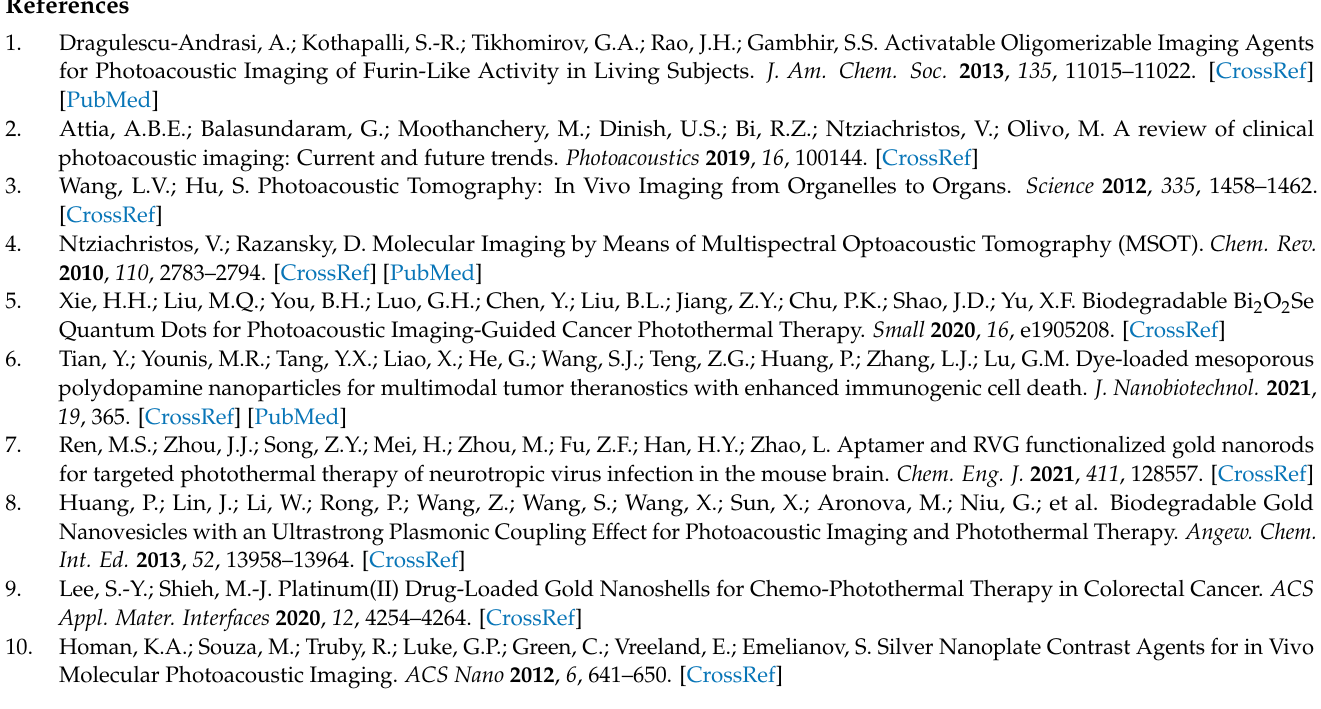
and transmission electron micrographs of the inclusions (b) Particle size test distribution of C1b ⊂ L. Figure S6. MCF-7 cell viability incubated with C1b ⊂ L measured by the CCK-8 assay. Results are presented as the mean ± SD in